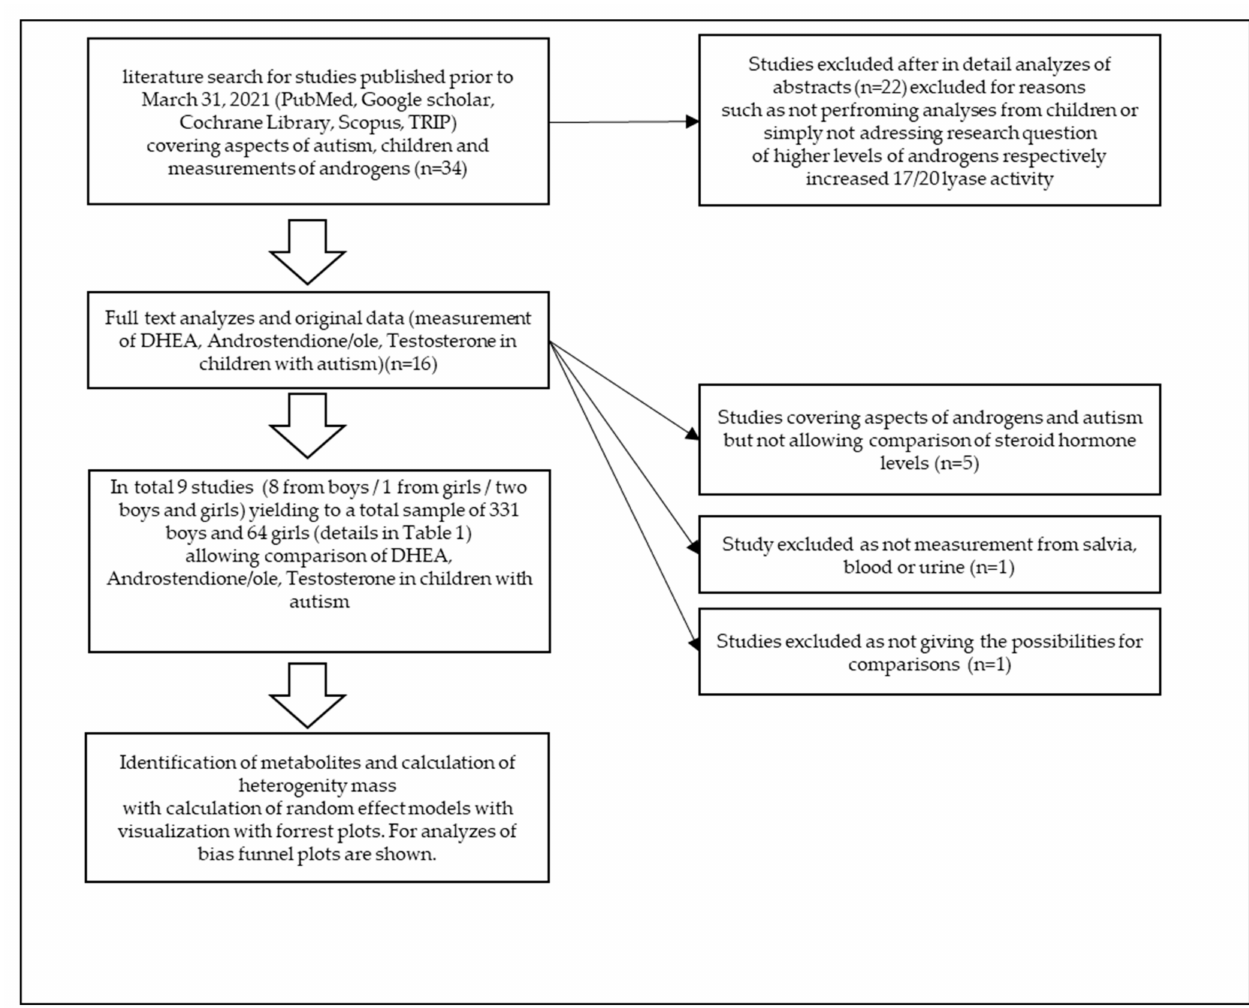
Figure 2. Flow diagram of meta-analysis